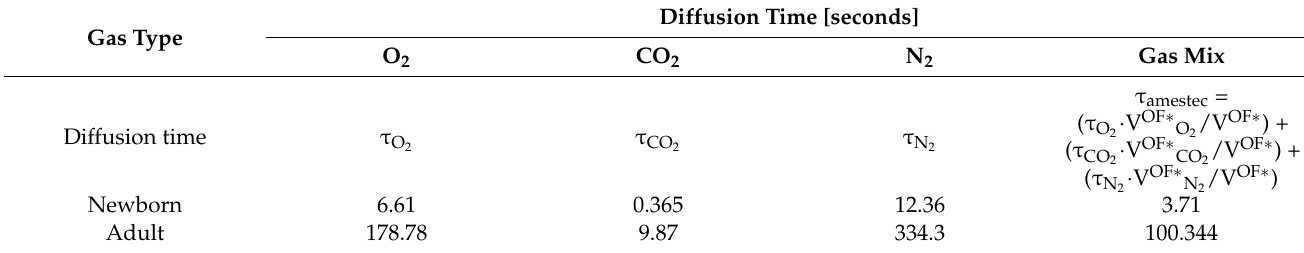
Table 1. Time τ for the bilateral transfer of the mass m ∆ of gas mix between the two thermodynamic systems ε T and M T